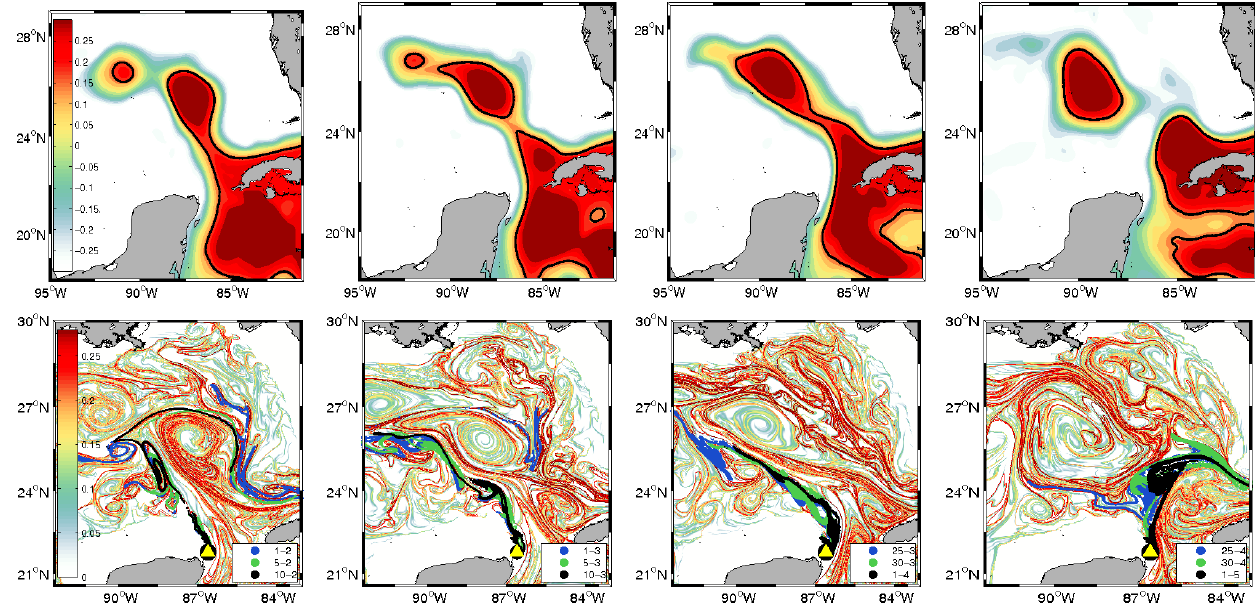
Fig. 5. Snapshots of SSH fields in m (top panel) and FTLE fields in d − 1 (lower panel) for the days indicated in Fig. 6c: 21 February, 19 March, 17 April and 12 May. SSH maps for March and April suggest the LCE separated while the FTLE maps and the particle trajectories clearly indicate there is no direct eastward intrusion of particles from the western side of the Yucatan Current until the final snapshot, where the LCE is totally separated (see text).